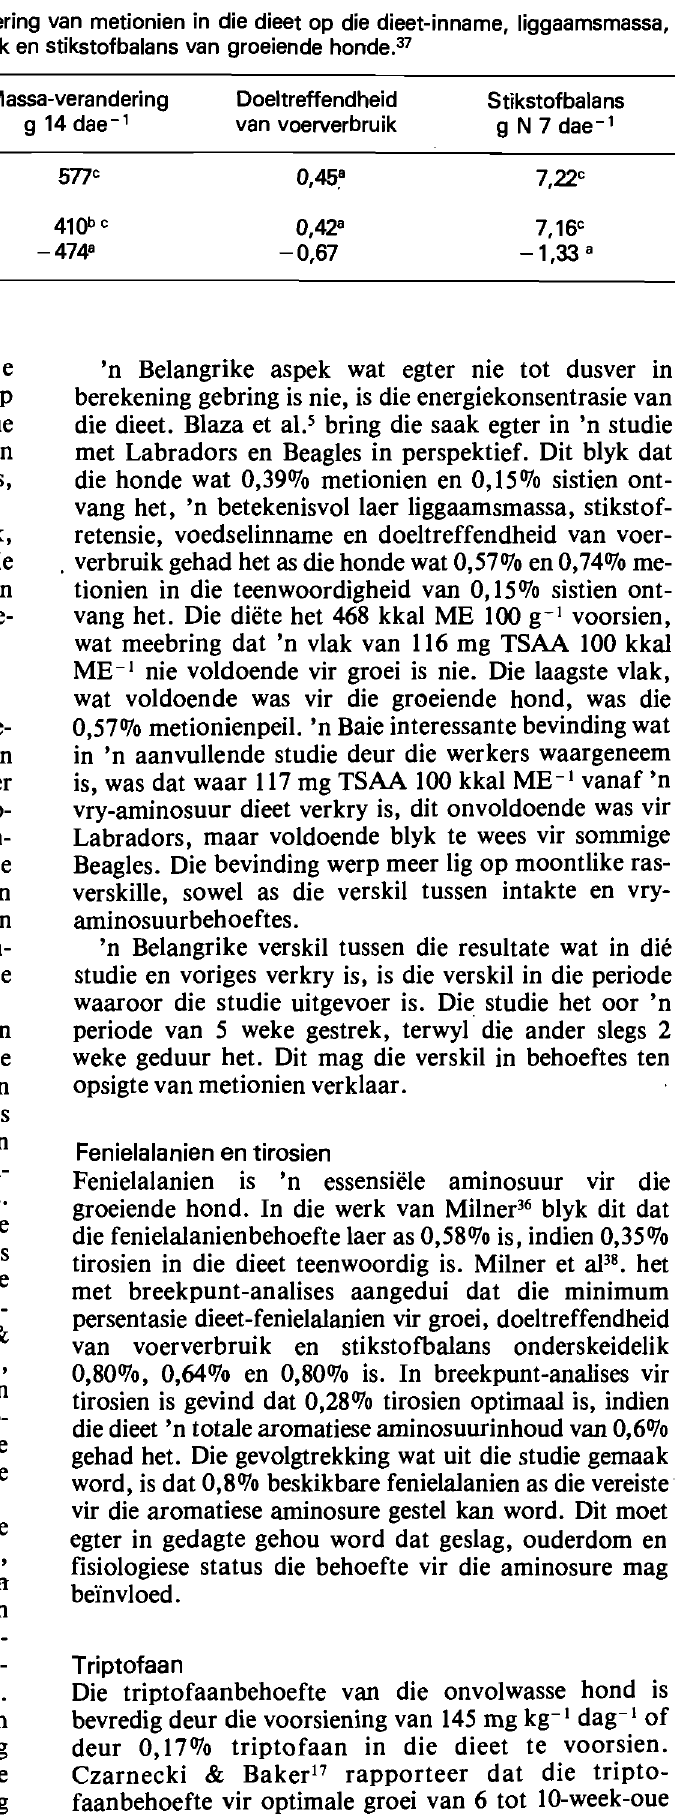
Tabel 11: Die invloed van 'n gedeeltelike of totale vel'V'!'Ydering van metionien in die dieet op die dieet-inname, liggaamsmassa, doeltreffendheid van voerverbruik en stikstofbalans van groeiende honde.